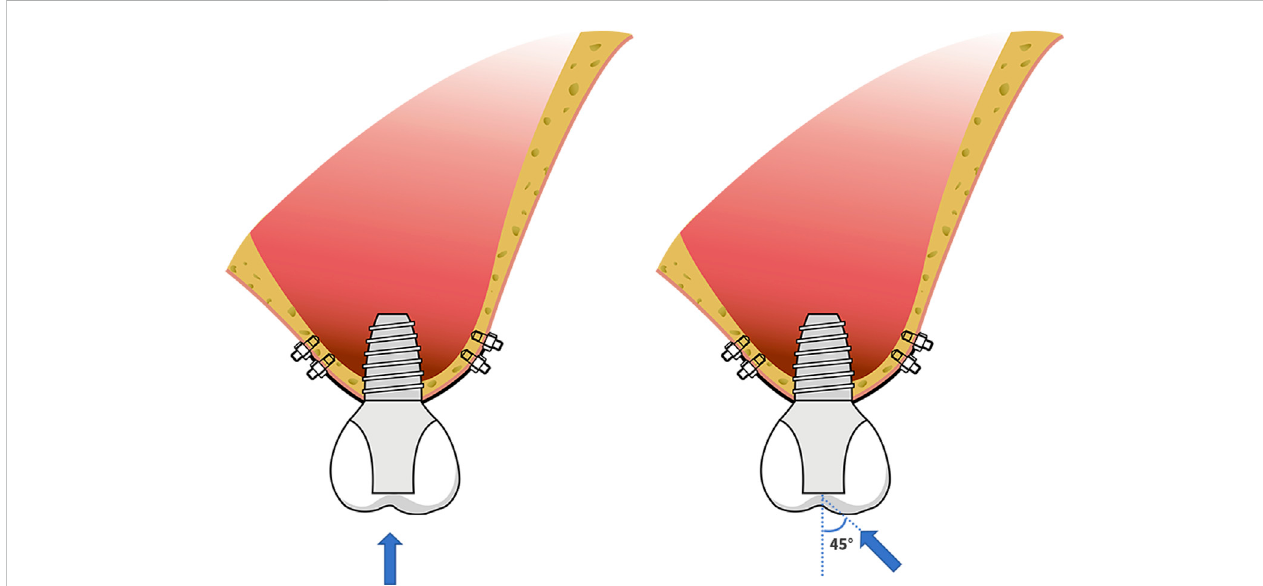
Schematic diagram of force loading; the force of 150 N loaded in a vertical direction on the top of the crown (0 ° ) and at an angle of 45 ° (45 ° ) to the long axis of the